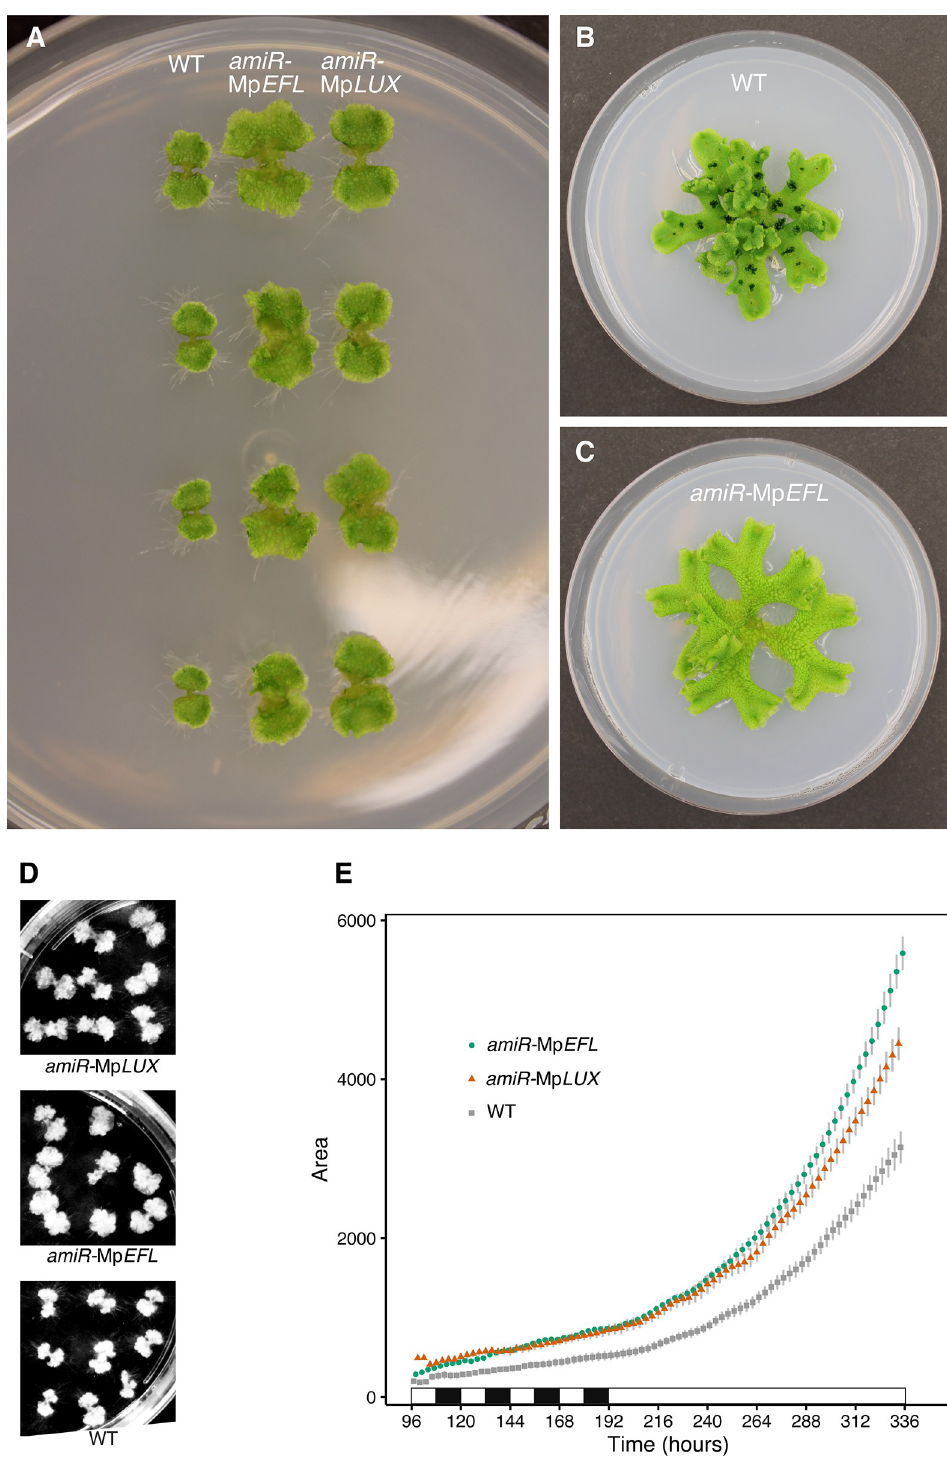
Fig 1. Evening complex knock-down mutants EF1 : amiR- Mp EFL MpMIR160 and EF1 : amiR- Mp LUX MpMIR160 pro pro display increased growth rate in Marchantia polymorpha gemmalings. (A) 2-week-old gemmalings of wild type : amiR- Mp EFL Mp MIR160 and EF1 : amiR- Mp LUX Mp MIR160 grown in ND on standard growth medium. (Upp5), EF1 pro pro (B) 6-week-old wild-type (Upp14) plant grown in LD on standard growth medium. (C) 6-week-old EF1 pro : amiR- Mp EFL Mp MIR160 #2 plant grown in LD on standard growth medium. (D) Images of assayed plants at end of growth-rate